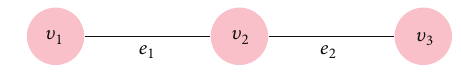
Figure 6: A network example illustrating fairness issues.